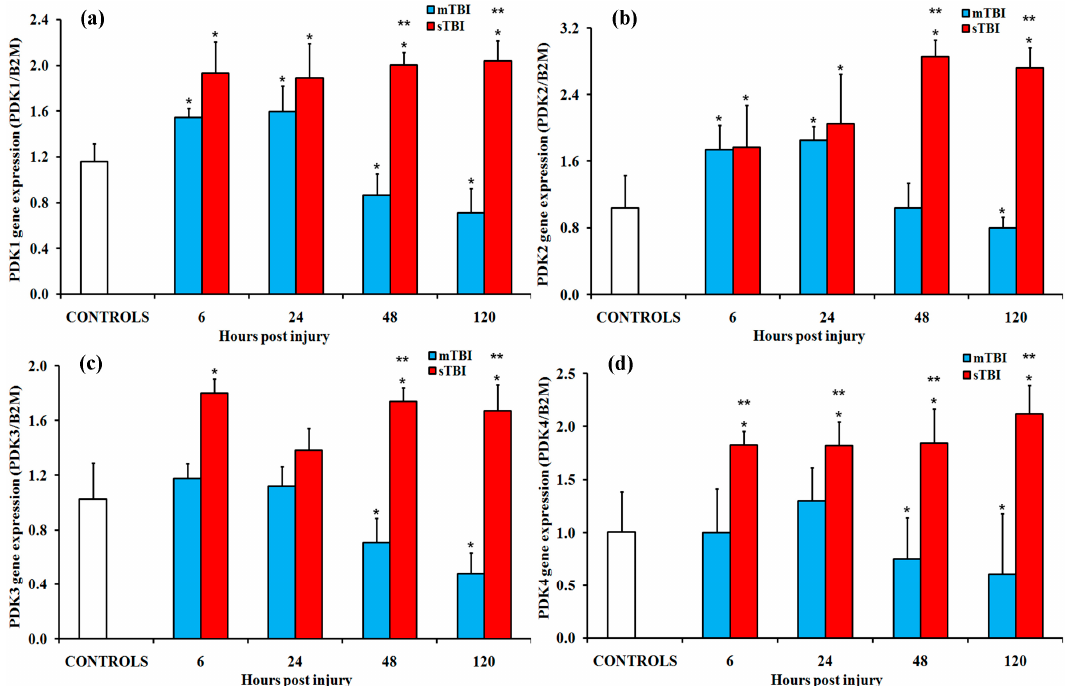
Figure 3. Changes in the expression of genes encoding for the four isoenzymes of pyruvate dehydrogenase kinase (PDK) in brain tissue homogenates of rats receiving a TBI of di ff erent severities (mTBI or sTBI) at various times post-injury. ( a ) PDK1, the gene encoding for isoform 1 of PDK; ( b ) PDK2, the gene encoding for isoform 2 of PDK; ( c ) PDK3, the gene encoding for isoform 3 of PDK; and ( d ) PDK4, the gene encoding for isoform 4 of PDK. Values are the mean of six animals. Standard deviations are represented by vertical bars. Gene expressions were calculated relative to the expression of the housekeeping gene β -2-microtubulin (B2M). * significantly di ff erent from the controls, p < 0.05. ** significantly di ff erent from the corresponding time of the mTBI rats, p < 0.05.